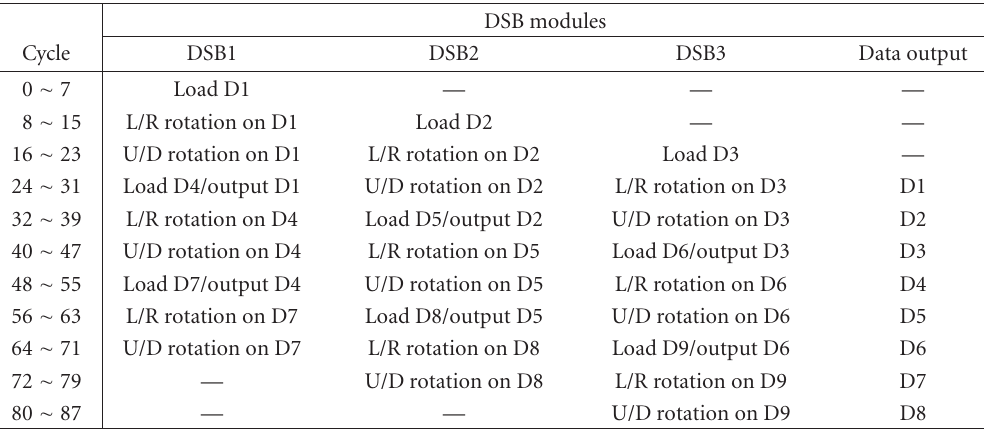
Table 5: The scheduling of DSB operations in the proposed design, where D n denotes the n th set (with 8 bytes in a set) of data. (a) Pipelining organization (using three DSBs as proposed in Figure